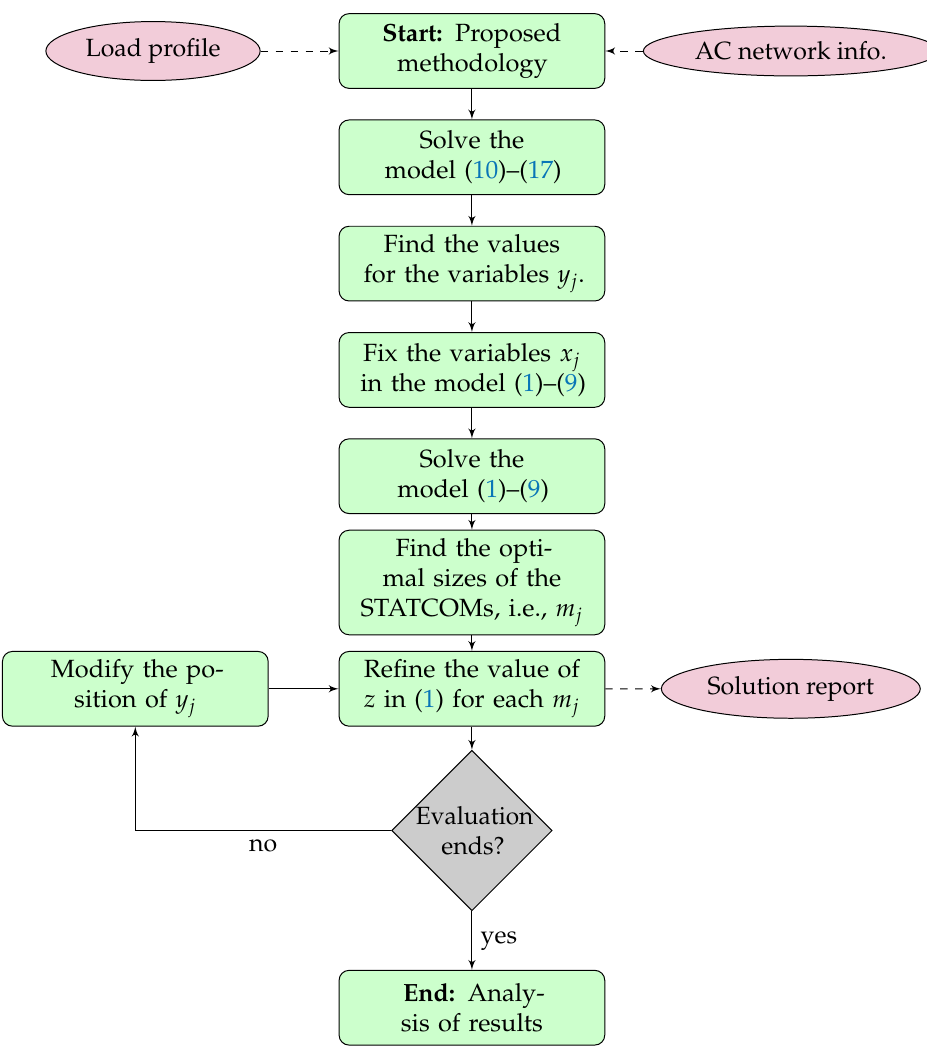
Figure 1. Main aspects of the proposed solution methodology.